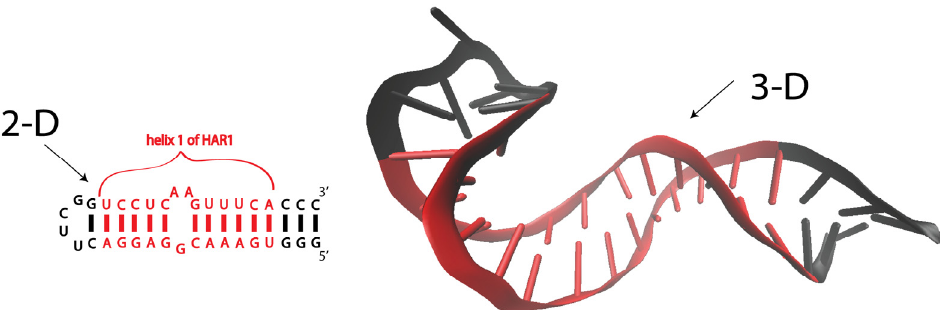
Figure 1. Secondary (2-D) and tertiary (3-D) folds of helix 1 of human HAR1 RNA. Nucleotides, denoted in red, belonging to a native helical region of HAR1 RNA. Nucleotides, denoted in black, are added in order to stabilize the entire construct for NMR. The NMR structure is adapted from Ziegeler et al .